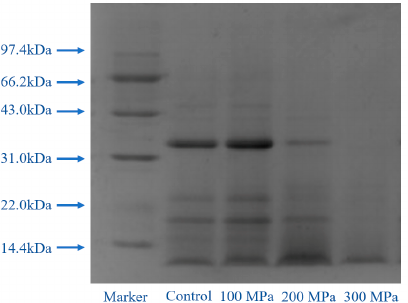
Figure 6. Effect of HHP pretreatment on the SDS-PAGE profiles of RBPH. HHP: high hydrostatic pressure; RBPH: rice bran protein hydrolysates; SDS-PAGE: sodium dodecyl sulfate-polyacrylamide gel electrophoresis. Control, 100 MPa, 200 MPa, and 300 MPa represent RBPH samples subjected to 0, 100, 200, and 300 MPa pretreatment, respectively. All the HHP pretreatments were conducted at 25 °C for 30 min.